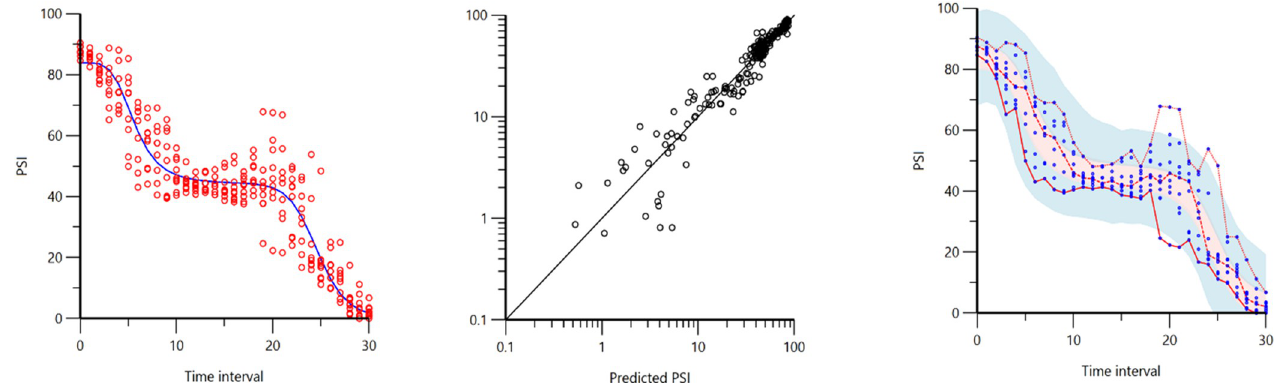
Fig 2. Pharmacodynamic modeling for patient state index (PSI). A. Observed data (circles) and prediction from the final population model (line) for PSI values during increasing propofol infusion rate. The time axis shows the normalized time intervals. B. Observed PSI data against individual-predicted values. C. Prediction-corrected visual predictive check (for 1000 simulations) of the final model for PSI; Blue dots = observations; red lines = 5 th , 50 th , and 95 th percentiles of the observed values; red/blue shaded area = 95% CI of the 5 th , 50 th and 95 th percentiles of the final prediction model.